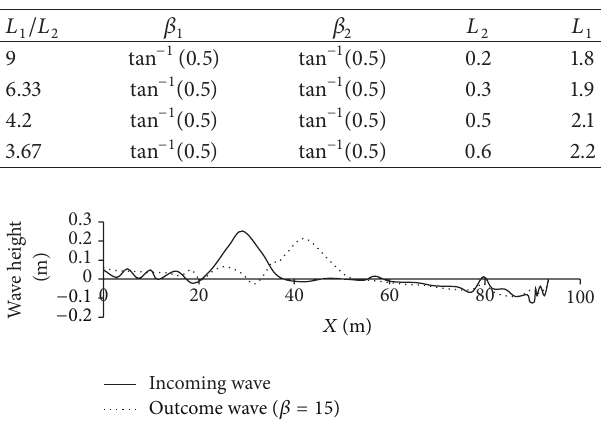
Figure 7: Free surface profile for 𝛽 2 = 15 degree.